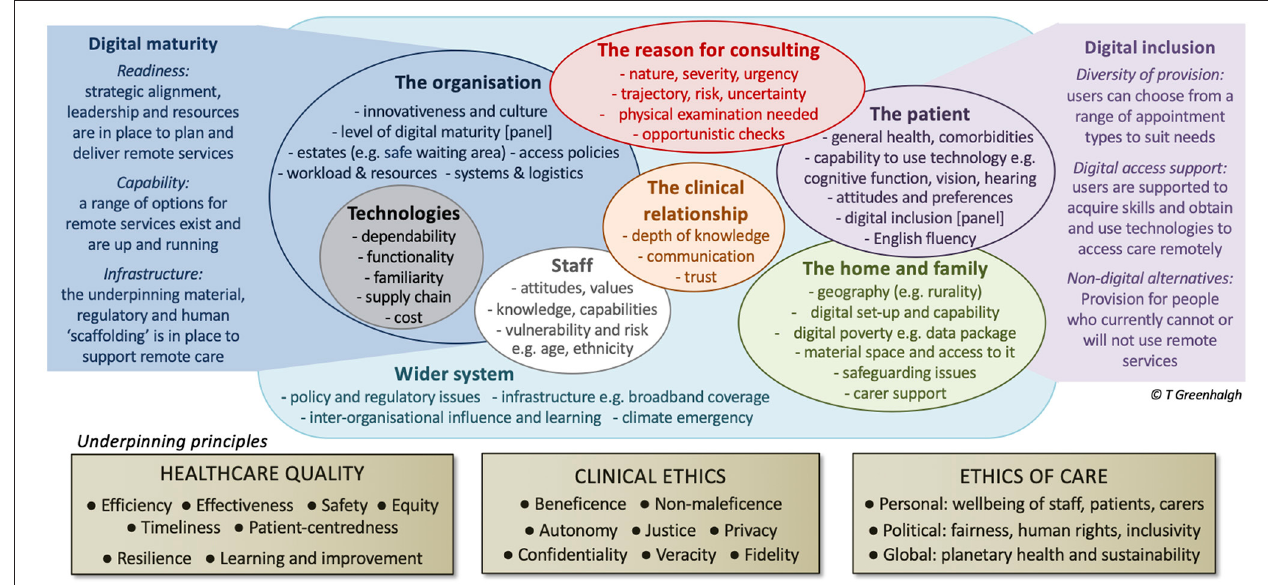
FIGURE 1 | The PERCS (Planning and Evaluating Remote Consultation Services) framework and underpinning principles of healthcare quality and ethics.